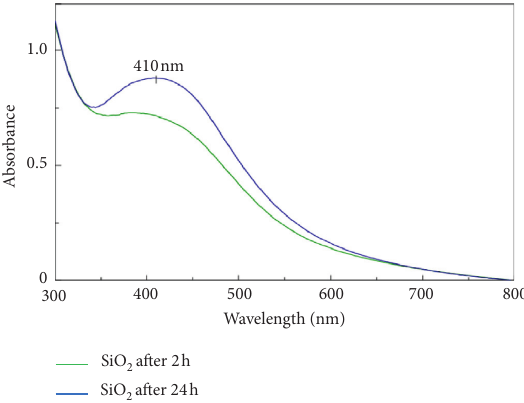
3 , SiO 2 , initial AgNO 3 -SiO 2 , and AgNO 3 -SiO 2 after 2 h.